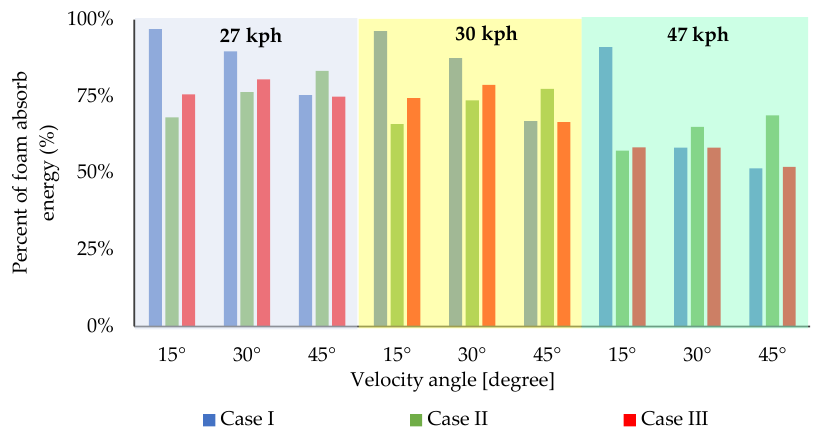
Figure 21. Energy absorption of the foam component in all three cases.